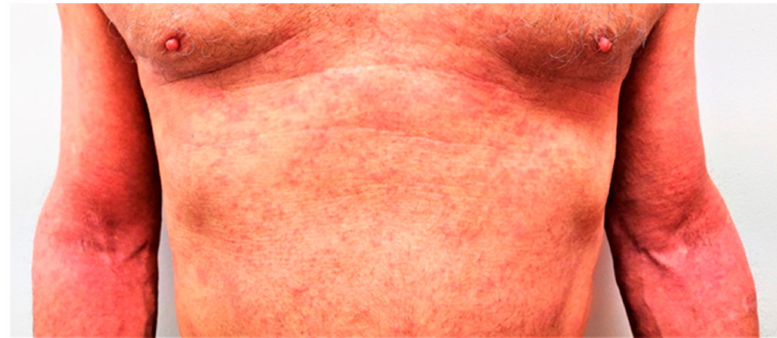
Figure 3. Patient before the initiation of dupilumab with EASI score of 32.9.